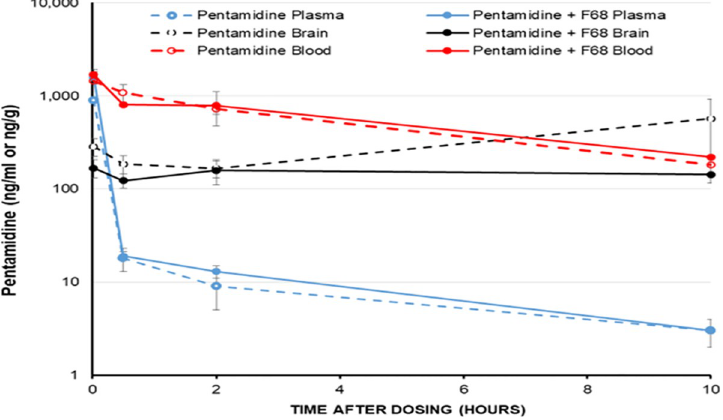
Fig 4. The effect of Pluronic F68 on pentamidine concentrations in CD1 mouse plasma, blood and brain after an intravenous dose. Each point represents an n of 3. 4mg/kg pentamidine ± 0.025% F68 i.v. Values ± SD.